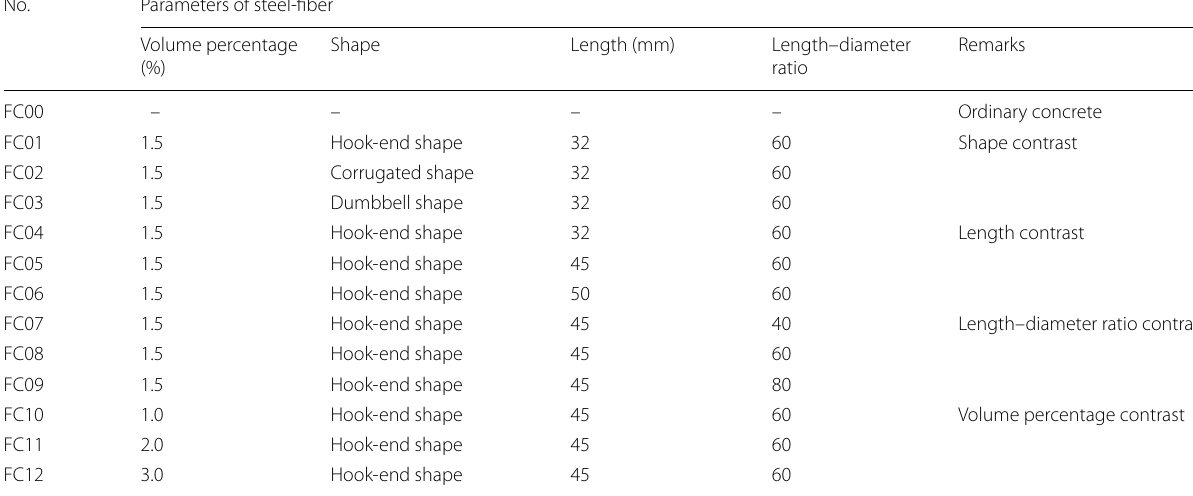
Table 1 The design and preparation scheme of steel-fiber concrete specimens. No.